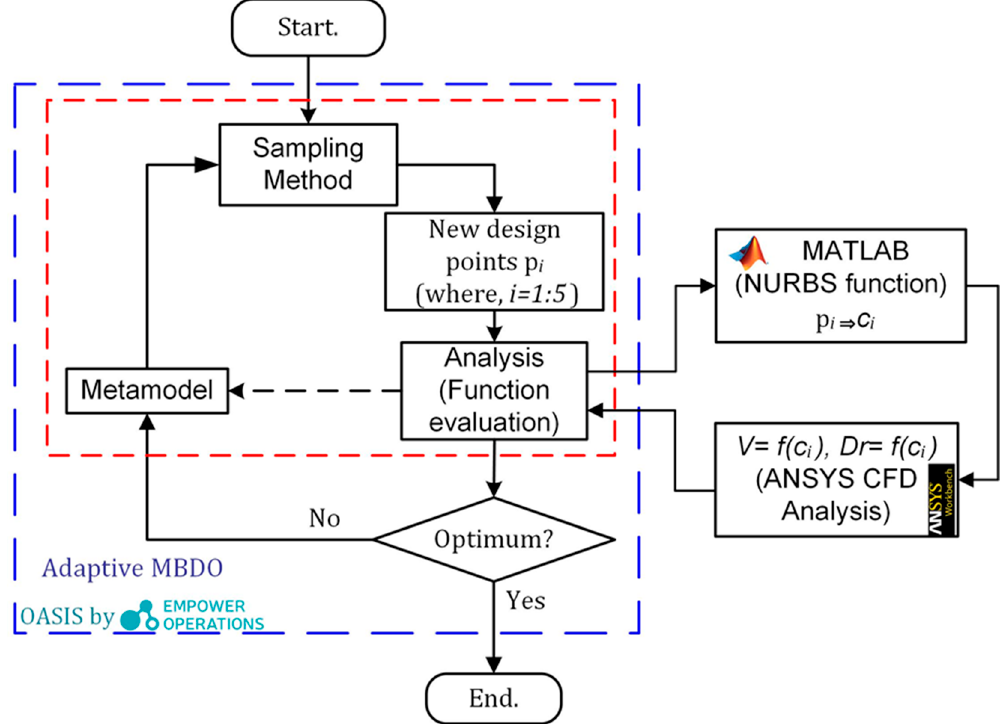
Figure 6. Optimization approach flowchart: inter-connection of OASIS, MATLAB and ANSYS Workbench tools.